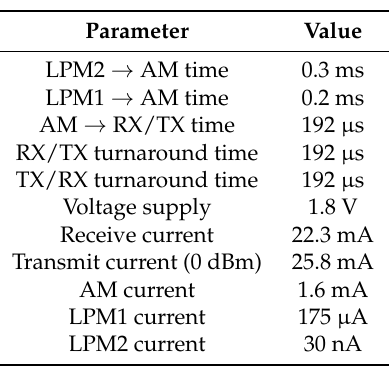
Table 1. Radio parameters. LPM, low power mode; AM, active mode.